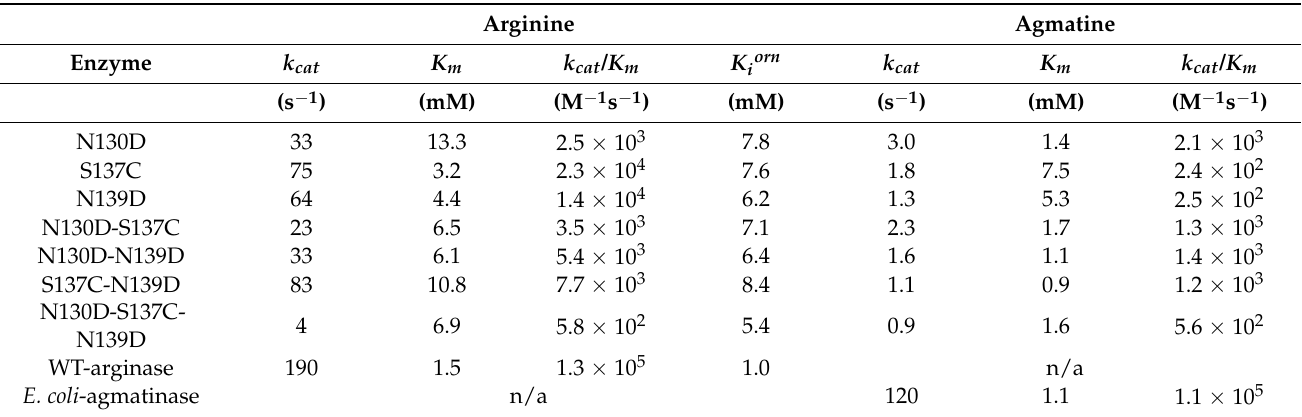
Table 1. Kinetic properties of the single, double, and triple mutants of the residues that bind the α -carboxyl of arginine in human arginase type